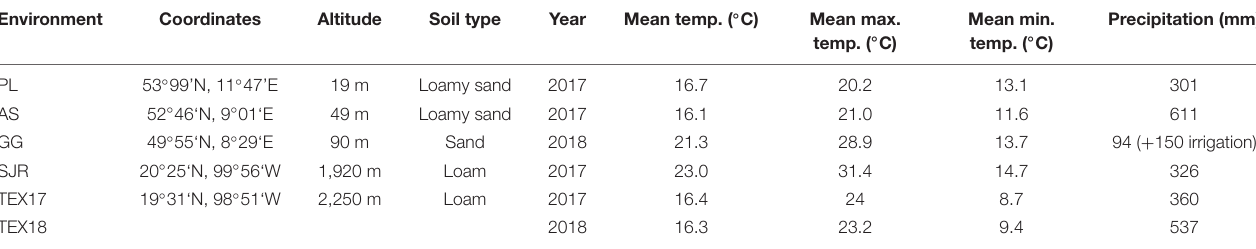
TABLE 1 | Overview and weather data of the different environments during the duration of the experiments (from sowing until harvest of the panicles).